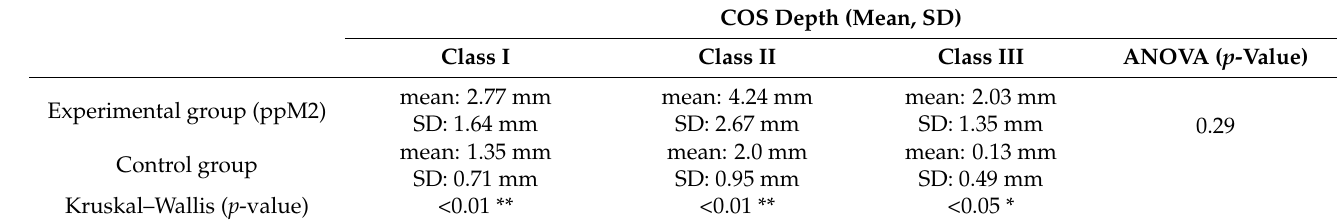
Figure 5. COS depth and angle-classification. Table 5. COS depth and angle-classification in experimental and control group.